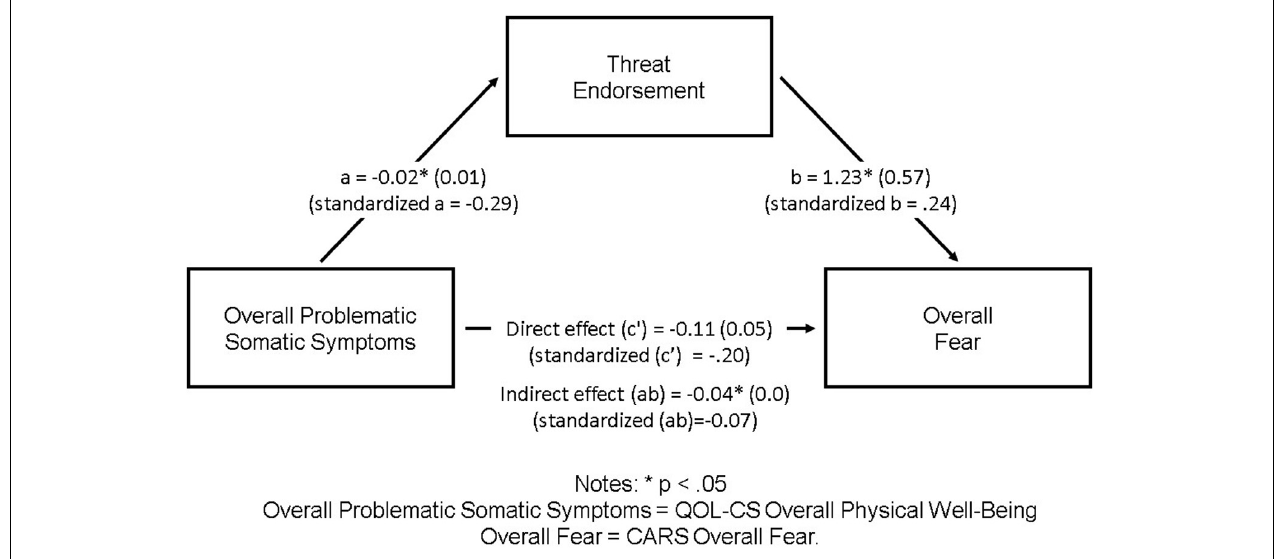
FIGURE 1 | Threat endorsement as a mediator of the association between overall problematic somatic symptoms and Overall Fear. ∗ p < 0.05. Overall problematic somatic symptoms, QOL-CS overall physical well-being; Overall Fear, CARS Overall Fear.